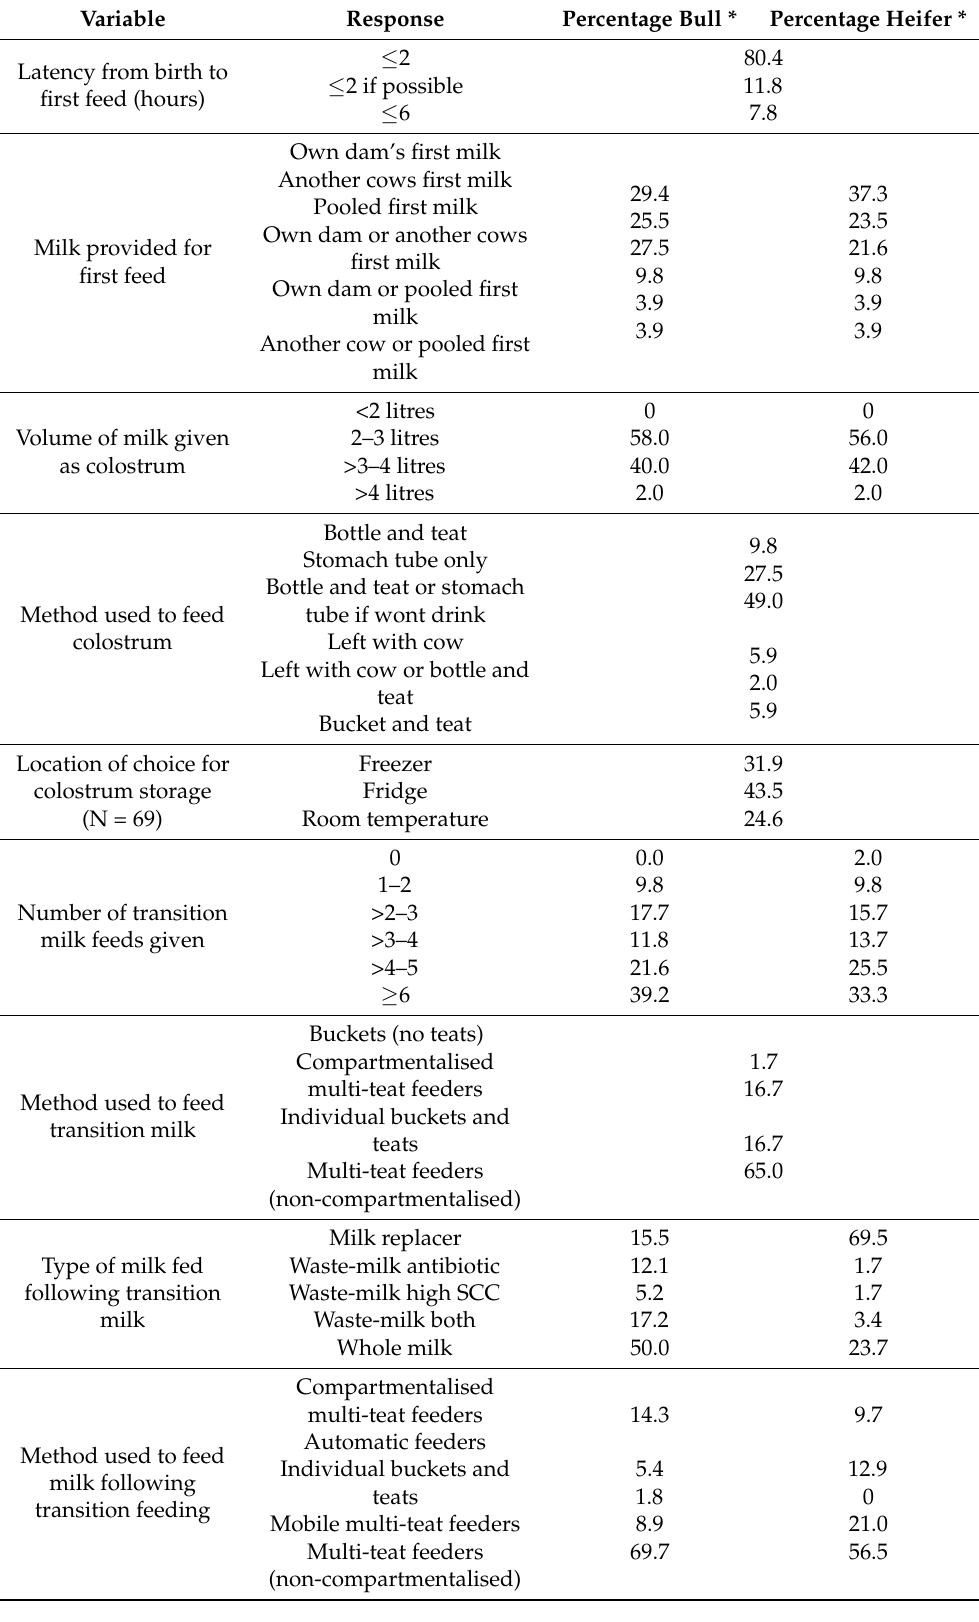
Table 5. Colostrum, transition, and general feeding practices for the surveyed farms (N = 51 unless otherwise